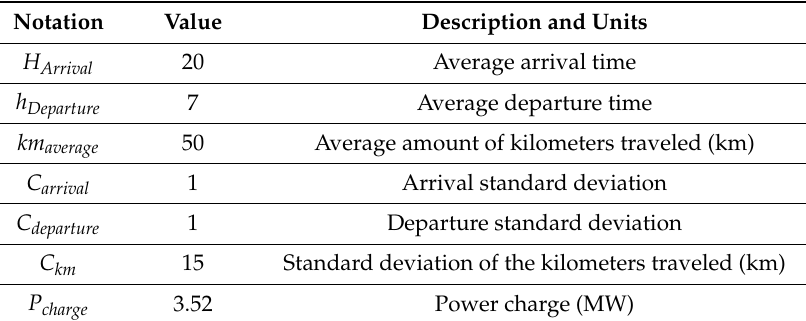
Table 7. Parameters of electric vehicles (for F 2 ( x )